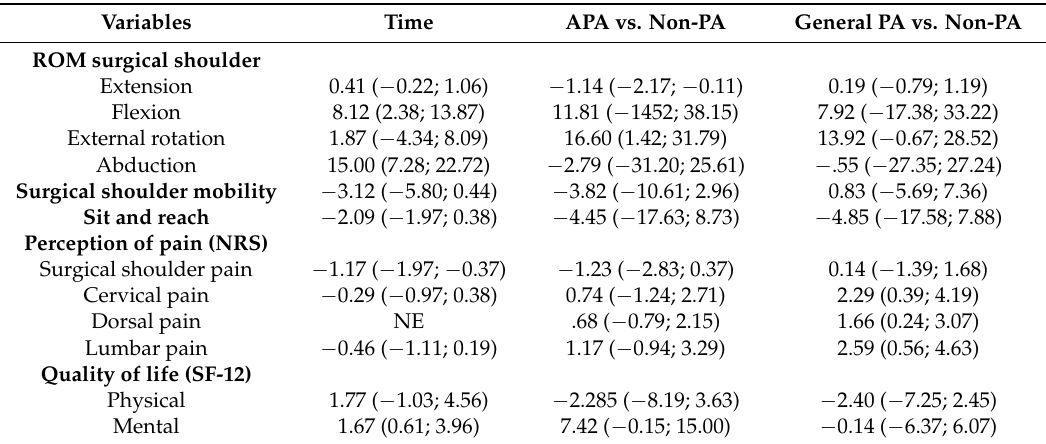
Table 6. Generalized estimating equations model for fitness tests, pain intensity, and quality of life questionnaires, adjusted for age and